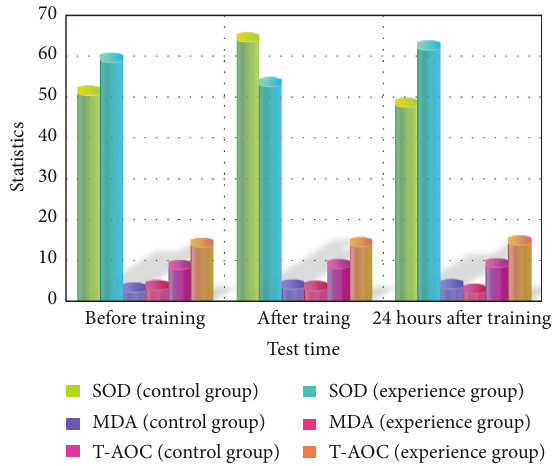
Figure 2: Statistical analysis of serum SOD and MDA concentrations in each group after the